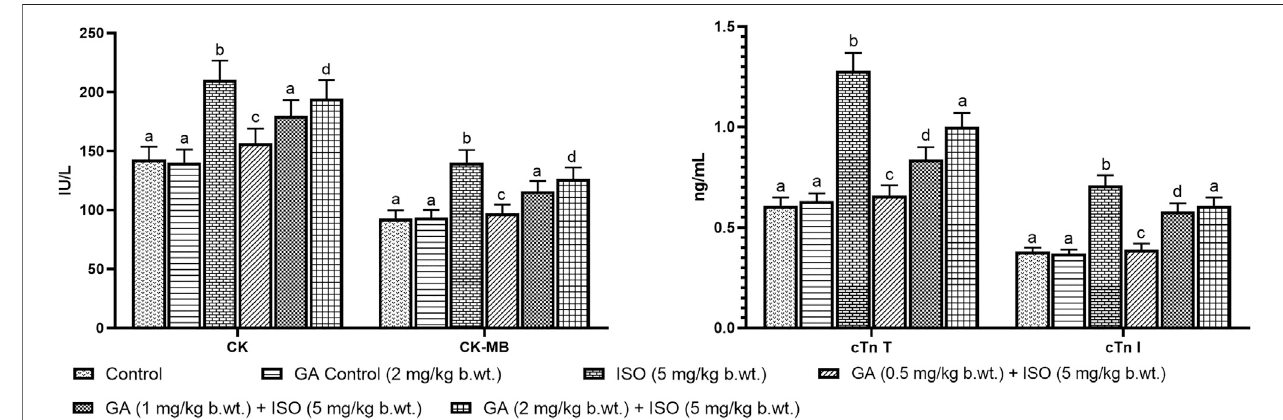
FIGURE 1 | Effect of GA on cardiac markers levels such as CK, CK-MB, cTnT and cTnI in the serum of control and ISO-induced rats. (A) Effect of GA on CK and CK-MB intheserumofcontroland ISO-induced rats. (B) EffectofGAoncTnTandcTnIintheserum ofcontrolandISO-induced rats.Valuesaregivenasmeans ± SDof six experiments in each group. Values not sharing a common superscript (a,b,c..) differ signi fi cantly at p ≤ 0.05